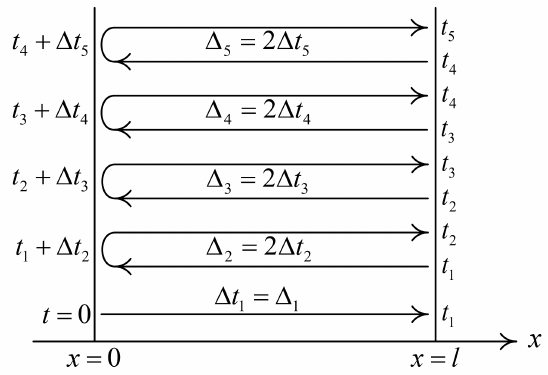
Figure 31. The propagation times for the pulse reflections.